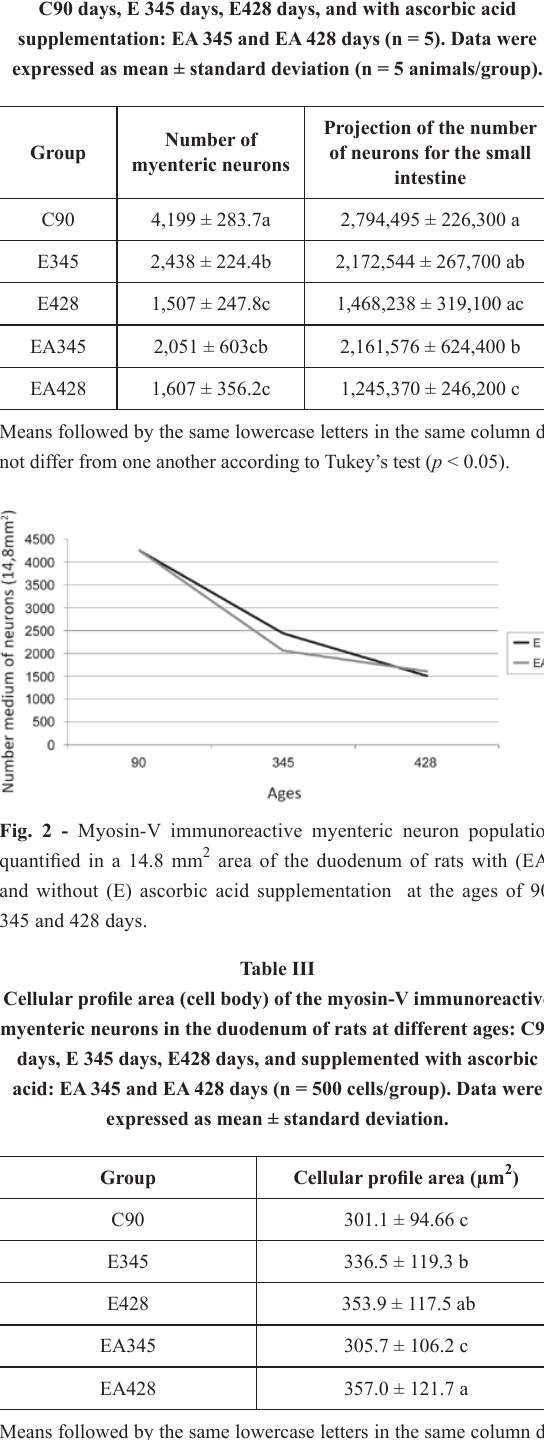
Means followed by the same lowercase letters in the same column do not differ from one another according to Tukey’s test (p<0.05).